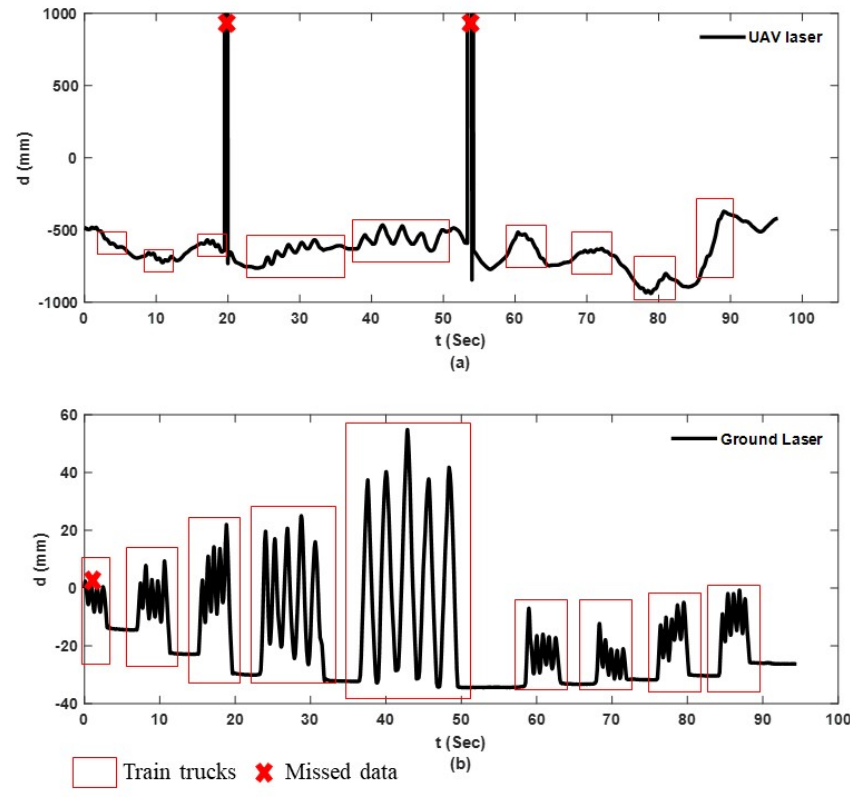
Figure 10. Rotational motion of the system during flight in degrees, experiment 2: ( a ) Roll angle; ( b ) Pitch angle; ( c ) Yaw angle.